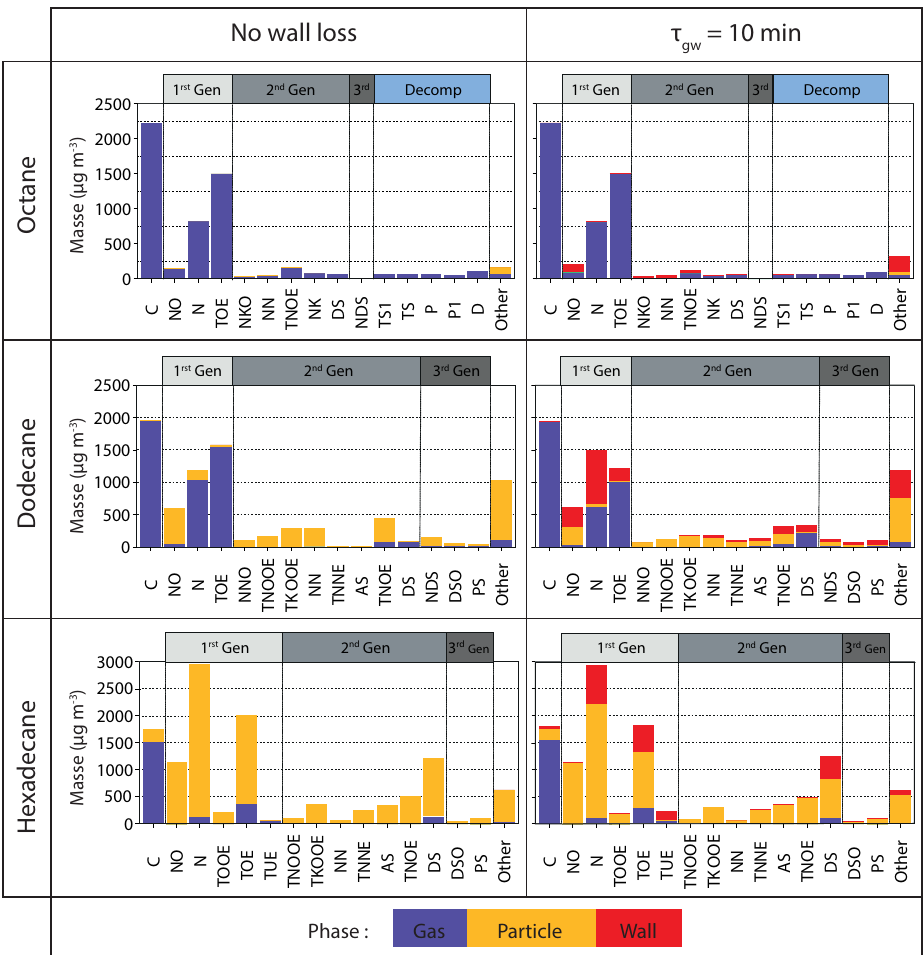
Particle WallPhase : Figure 8. Distribution of the top 15 species between the gas phase (purple), the particle phase (yellow) and the walls (red) at the end of the simulations for n-octane (C 8 ) , n-dodecane (C 12 ) and n-hexadecane (C 16 ) . Simulated results are reported in mass concentrations (in µgm − 3 of air or equivalent for the Teflon phase) for simulations conducted without wall loss (left panel) and with partitioning to the wall using τ gw = 10min and C w /(M w γ w ) = 120µmolem − 3 (right